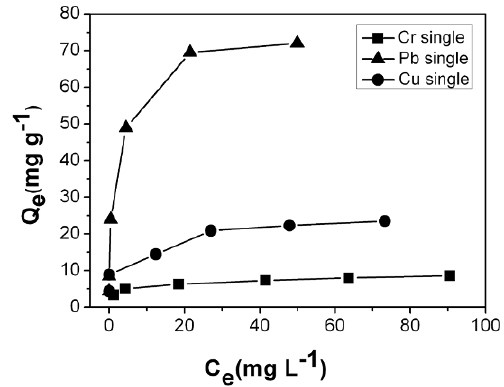
Figure 7. Adsorption isotherms for single-component solutions of Cu(II) - ● , Cr(III) - ■ and Pb(II) - ▲ onto